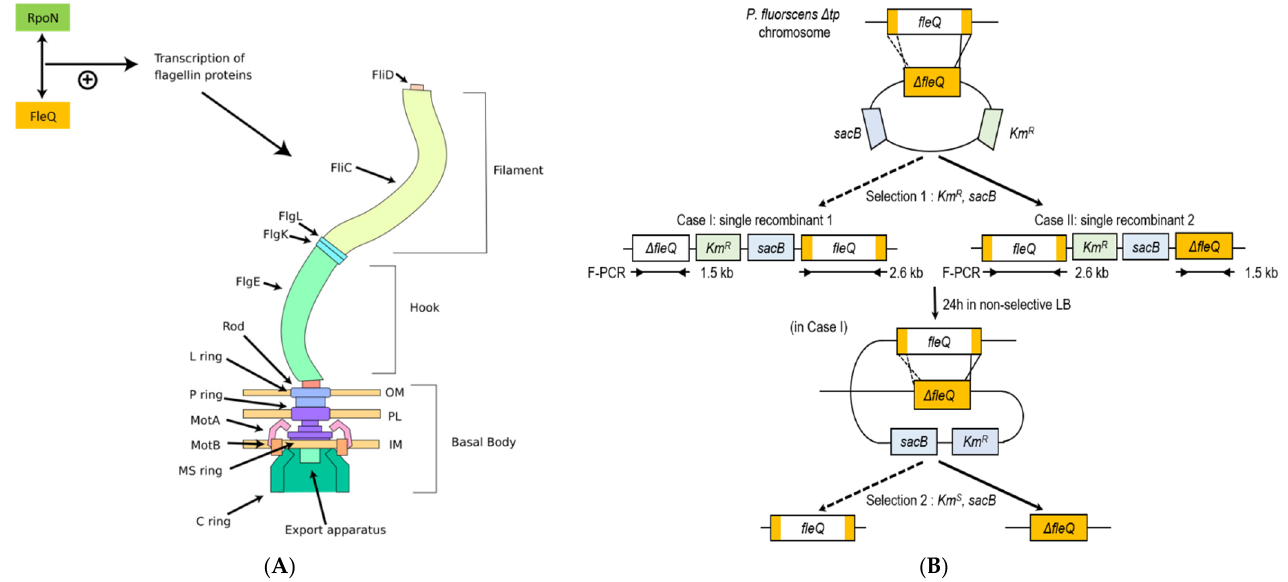
Figure 2. FleQ-regulated flagellin assembly and construction of the P. fluorescens Δ fleQ mutant. ( A ) Simplified model depicting the role of FleQ in flagella synthesis and the location of FliC in the flagella structure. FleQ and RpoN positively regulate expression of flagella genes. ( B ) The deletion process to create P. fluorescens Δ fleQ and the location of primer-specific sequences used for PCR verifications.